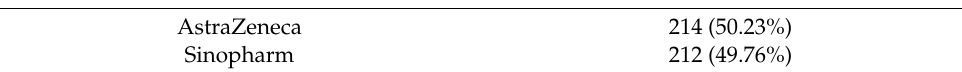
Table 2. Vaccine preference among respondents.